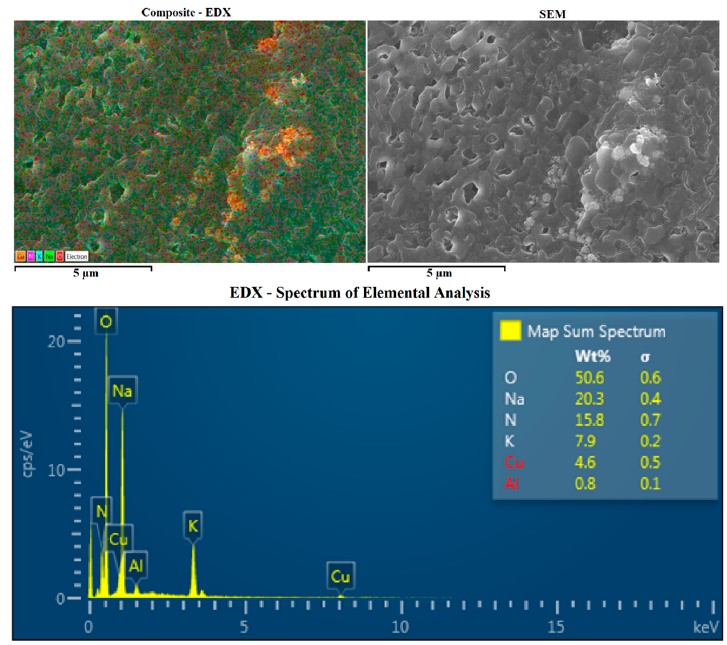
Figure 2. EDX Analysis of salt mixture (60% NaNO 3 and 40% KNO 3 ) with 1.65 wt. % CuO. The composite picture is an overlay of the SEM and the elemental analysis of the sample. The presence of aluminum come from the SEM stub.